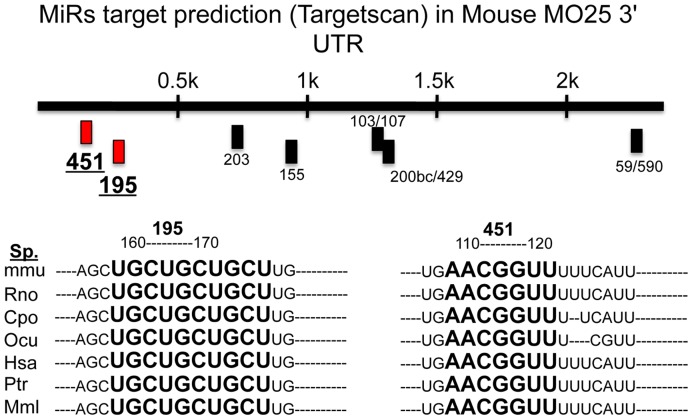
MiRs, including miR-195 and -451, target prediction (Targetscan) in murine MO25 3′ UTR.
Top panel: Putative binding sites for miR-195 and miR-451 (underlined) are highlighted in red. Bottom panel: Sequence alignment (indicated in boldface and large lettering) of putative miR-195 and miR-451 binding sites in 3′ UTR of MO25 of several species, showing a high level of sequence conservation.